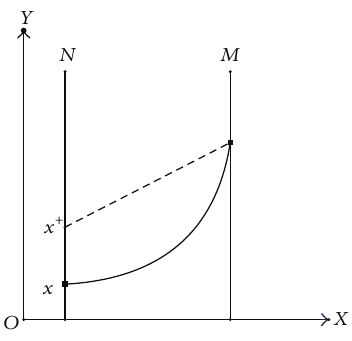
Figure 1: The successor function of system (2).